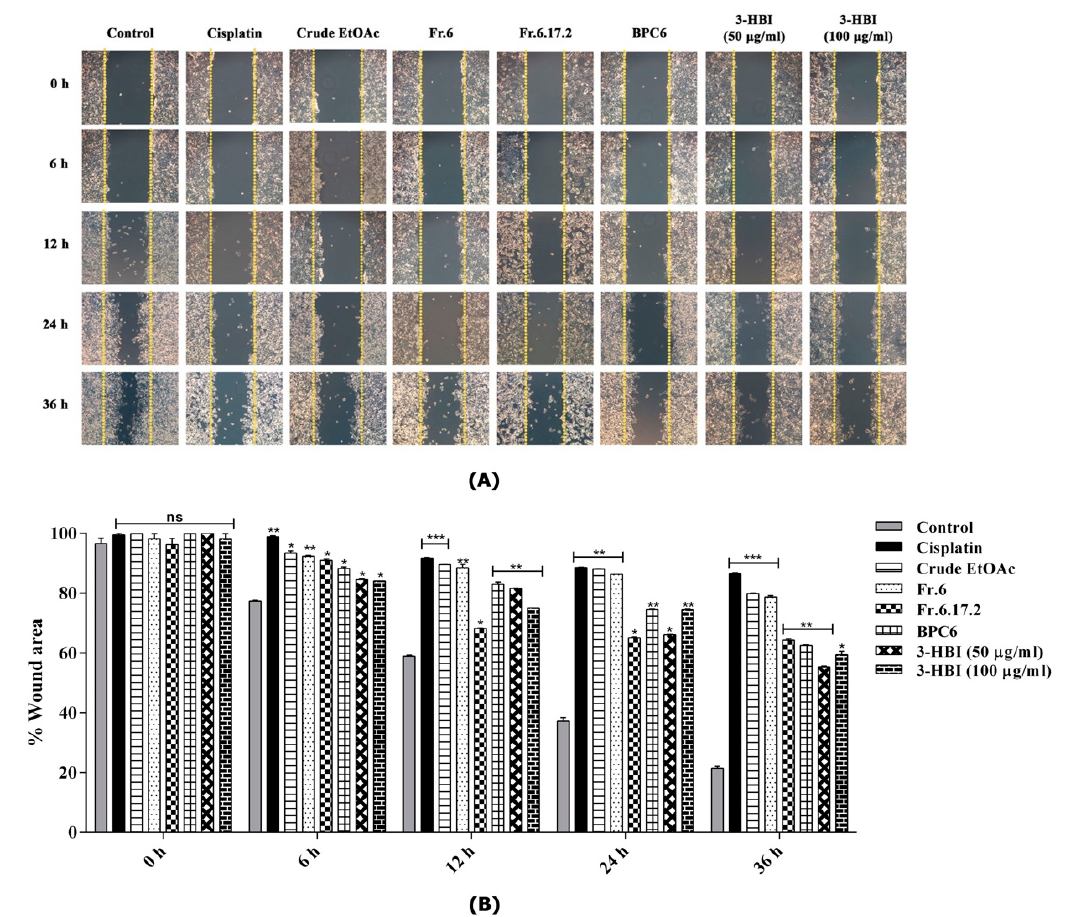
Figure 6. Wound closure analysis of SCC15 cell line for untreated control and cells treated with MO extract, fraction no. 6, sub-fraction no. 6.17.2, BPC 6 and 3-HBI for 36 h. ( A ) Pictures of wound area were taken at 0, 6, 12, 24 and 36 h with an inverted microscope. ( B ) Size of wound area was measured using ImageJ system software. Percentage of wound area was calculated, and bar graphs were represented as means ± SEM. ns = not significant, * p ≤ 0.05, ** p ≤ 0.01, and *** p ≤ 0.001 compared to control. Control: untreated SCC15; crude EtOAc: crude ethyl acetate; Fr.6: fraction no. 6; Fr.6.17.2: sub-fraction no. 6.17.2; BPC6: base peak chromatogram no. 6; 3-HBI: 3-hydroxy- β -ionone.